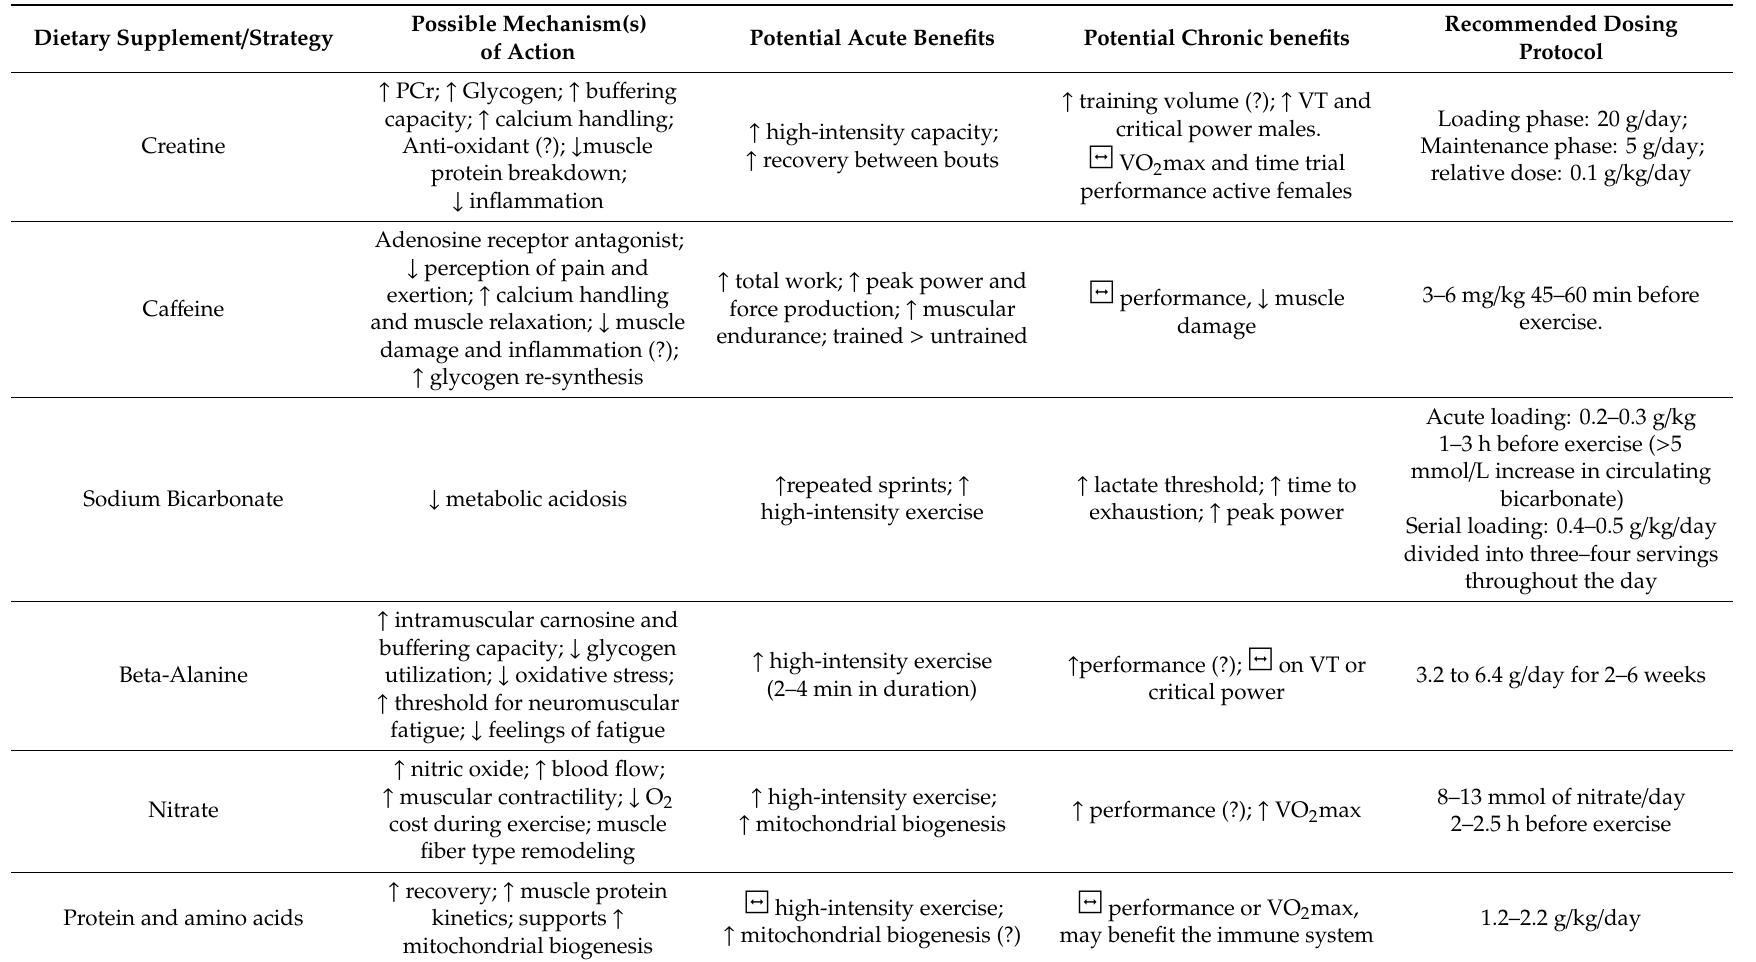
Table 1. List of potential dietary supplements to augment acute and chronic high-intensity interval training.